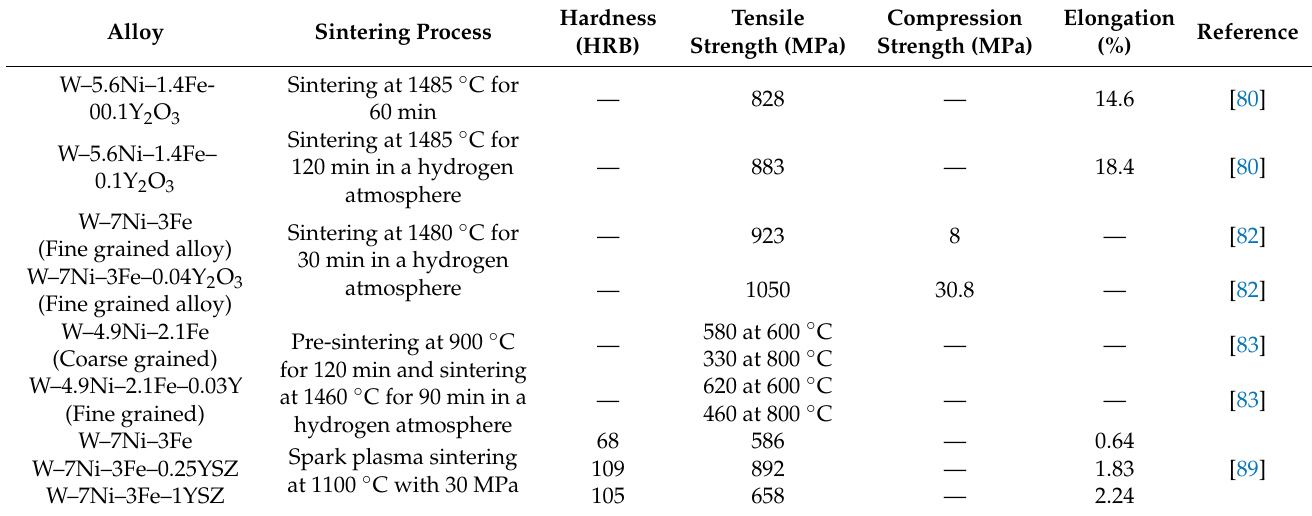
Figure 13. The adiabatic shear band is visible in the specimen dynamically tested at a strain rate of 1.9 × 10 3 s −1 [87]. Reproduced with permission from Gong et al., Materials Science and Engineering: A; published by Elsevier, 2010. Table 5. Mechanical properties of W–Ni–Fe with yittrium and Y 2 O